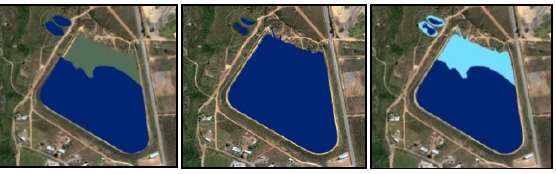
Figure 8. Left: Topographic data (2010), Middle: Classified waterbodies, Right: Changes highlighted (light blue) WorldView-2 Image Copyright 2014, DigitalGlobe